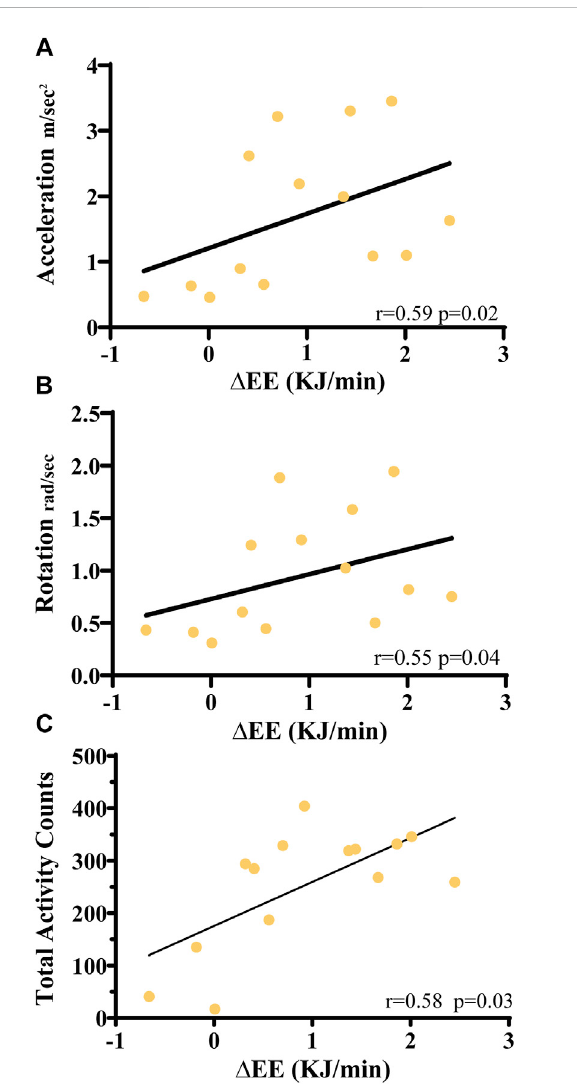
FIGURE 7 Linear regression analysis of Δ EE values with (A) average acceleration values, (B) average rotation levels and (C) acceleration- derived average total activity counts for exercise 2. Coef fi cients of determination (r2) and the statistical signi fi cance p -value are